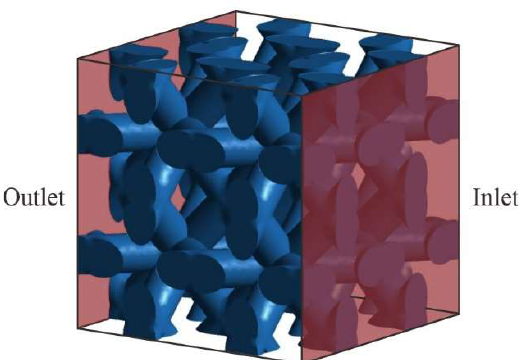
Figure 2. A numerical simulation area with the dendritic lattice of 2 × 2 × 2 = 8 units. Streamline distributions of the molten aluminum were visualized by computer fluid dynamics (CFD). Temperature and pressure distributions on the lattice surfaces were estimated using the finite element method (FEM).